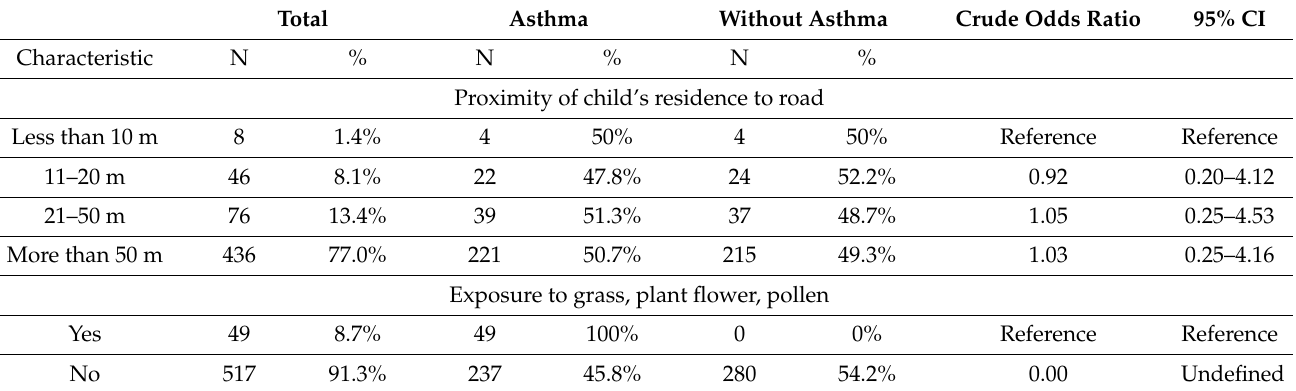
Table 5. Distribution and Crude Odds Ratios of Participants by Asthma and outdoor environmental